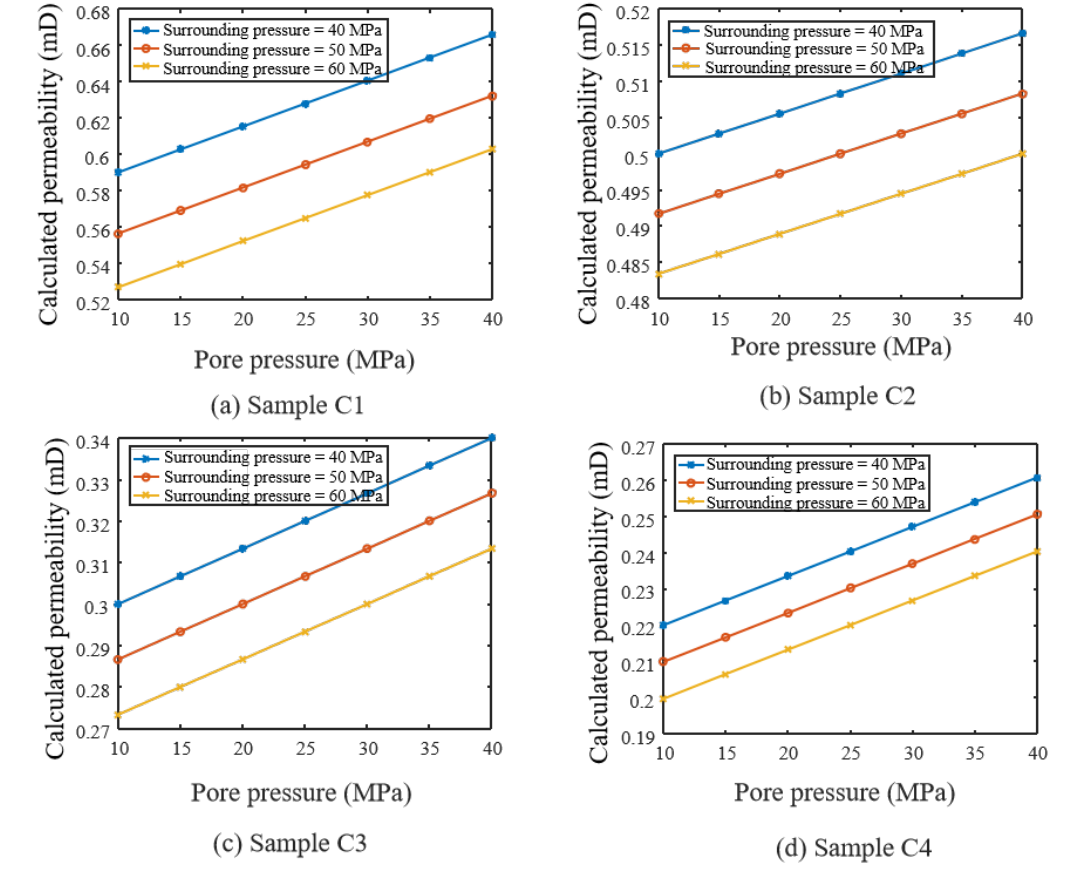
Figure 14. Variation curve of permeability with pore pressure and surrounding pressure ( a ) Sample C1, ( b ) Sample C2, ( c ) Sample C3, ( d ) Sample C4.